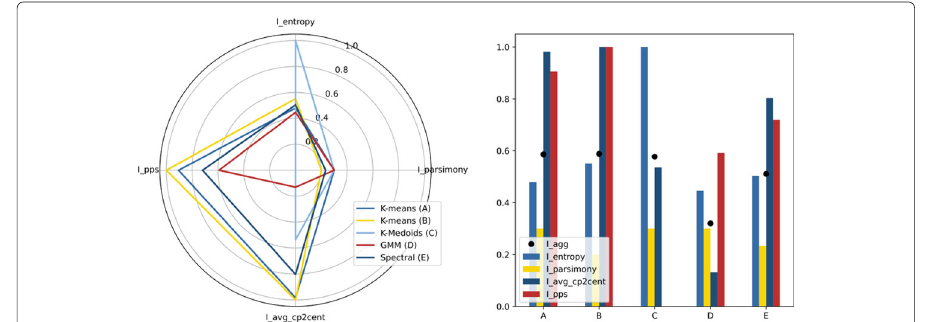
Fig. 4 Cluster validation indices for bidirectional load profiles of electric